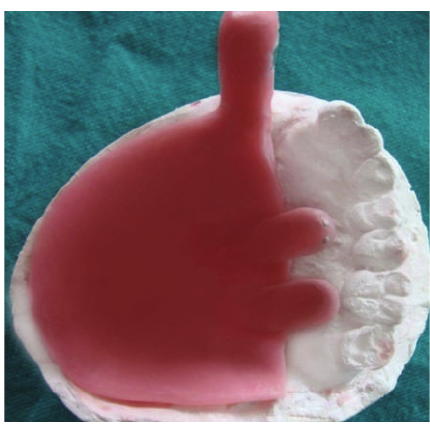
Figure 7: Male part.